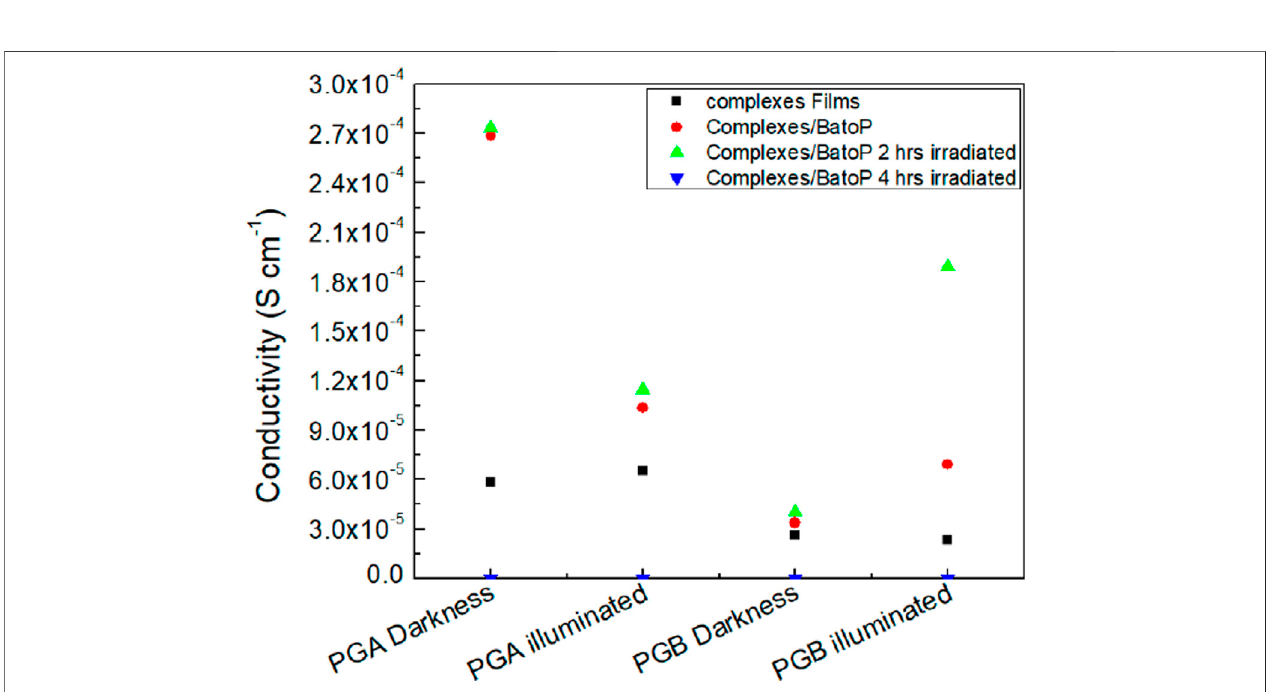
Frontiers in Materials |